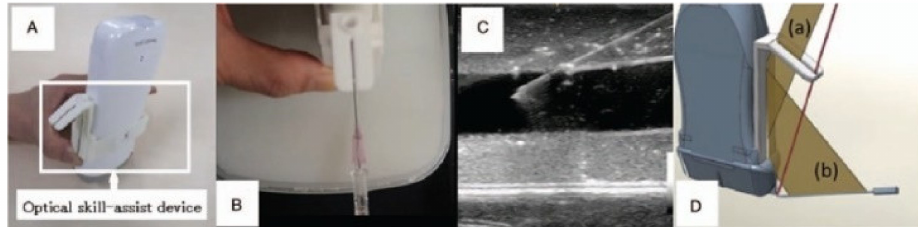
Figure 18. Central vein catheterization access point simulator ( A ) ultrasound emulator ( B ) CVC pad ( C ) Ultrasound image of simulator ( D ) diagram showing how the device is placed [33].